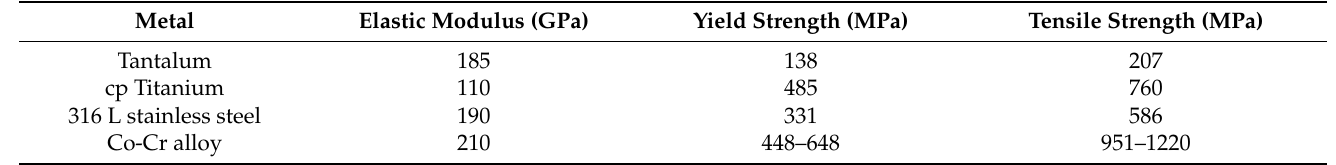
Table 1. Main mechanical properties of tantalum and other metals for biomedical use